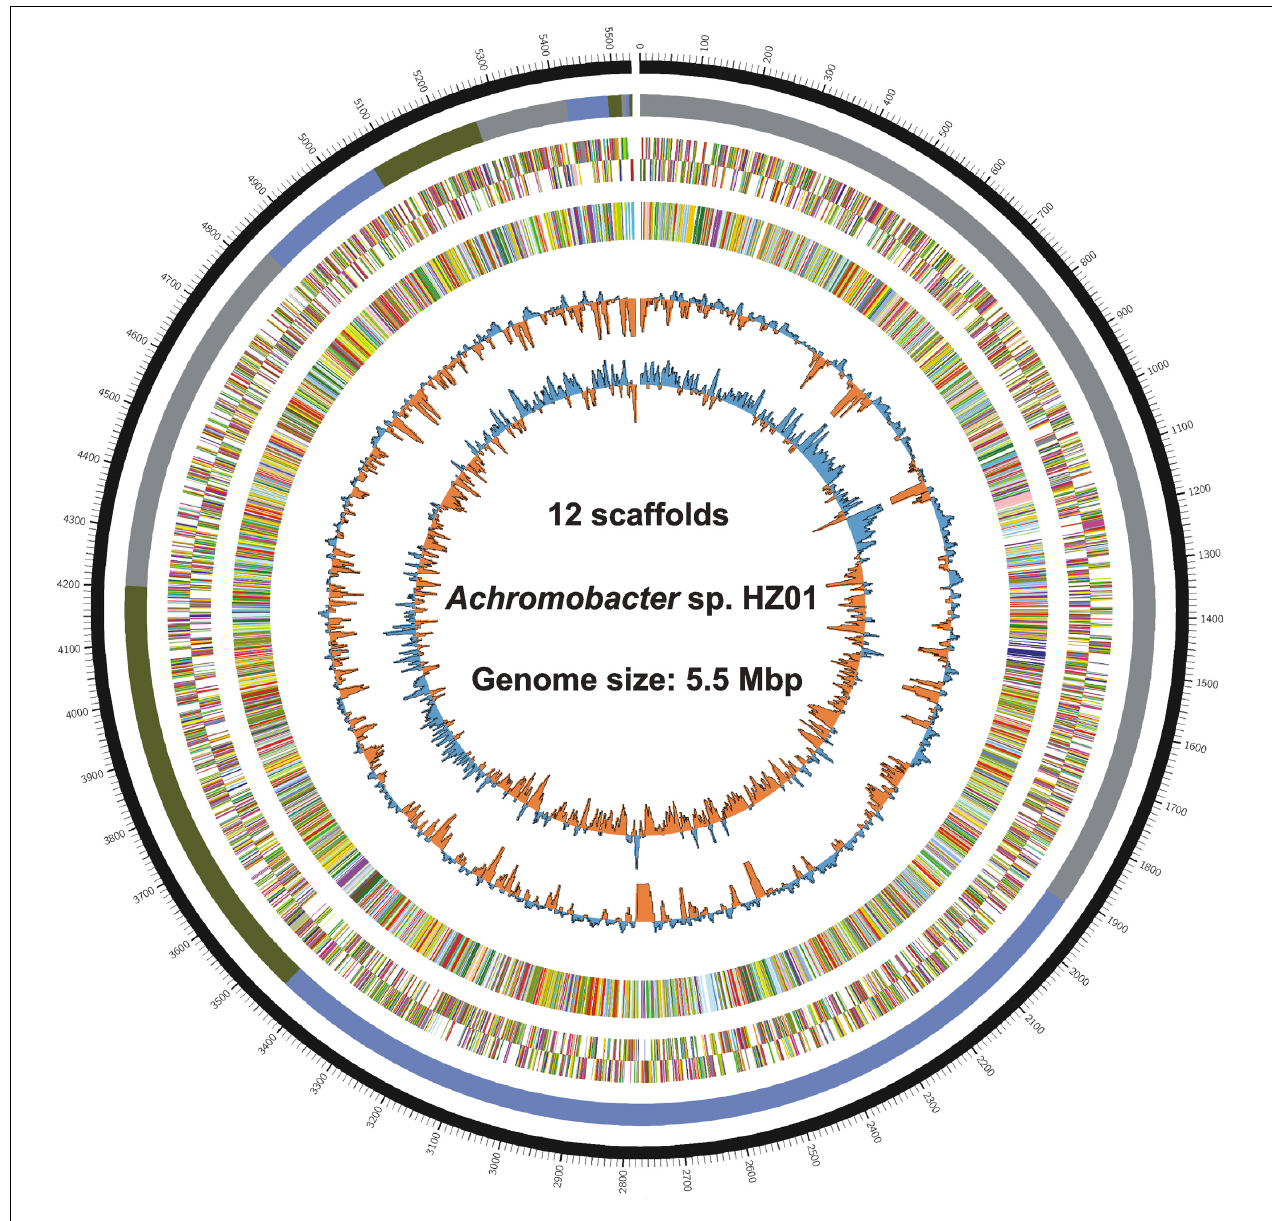
FIGURE 1 | Circular chromosome of Achromobacter sp. HZ01. The circular genome map from the outside inward: ring 1, genomic position; ring 2, assembled scaffolds in order of size; rings 3 and 4, predicted genes on the forward (ring 3) and the reverse (ring 4) strands; ring 5, genes assigned to COG categories; ring 6, GC content; ring 7, GC skew. The circular map was generated by Circos v0.65 (Krzywinski et al.,